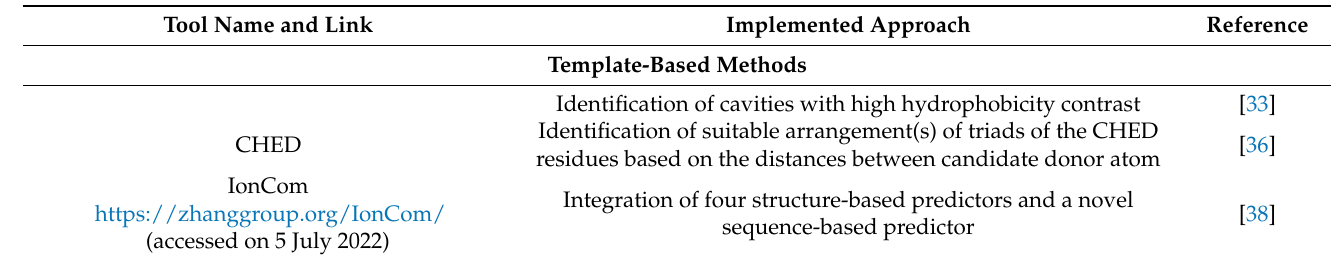
Table 1. Summary of all of the resources mentioned in this article. The resources are listed in the same order as they are discussed in the corresponding sections. Only links active as of 15 June 2022 are